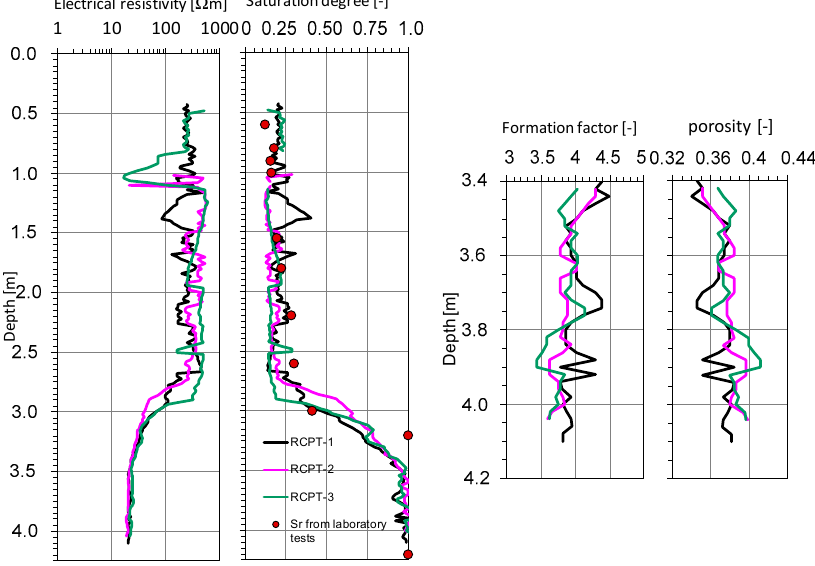
Figure 11. Results of RCPT tests; electrical resistivity of sands with calculated / measured saturation degree, formation factor and porosity of